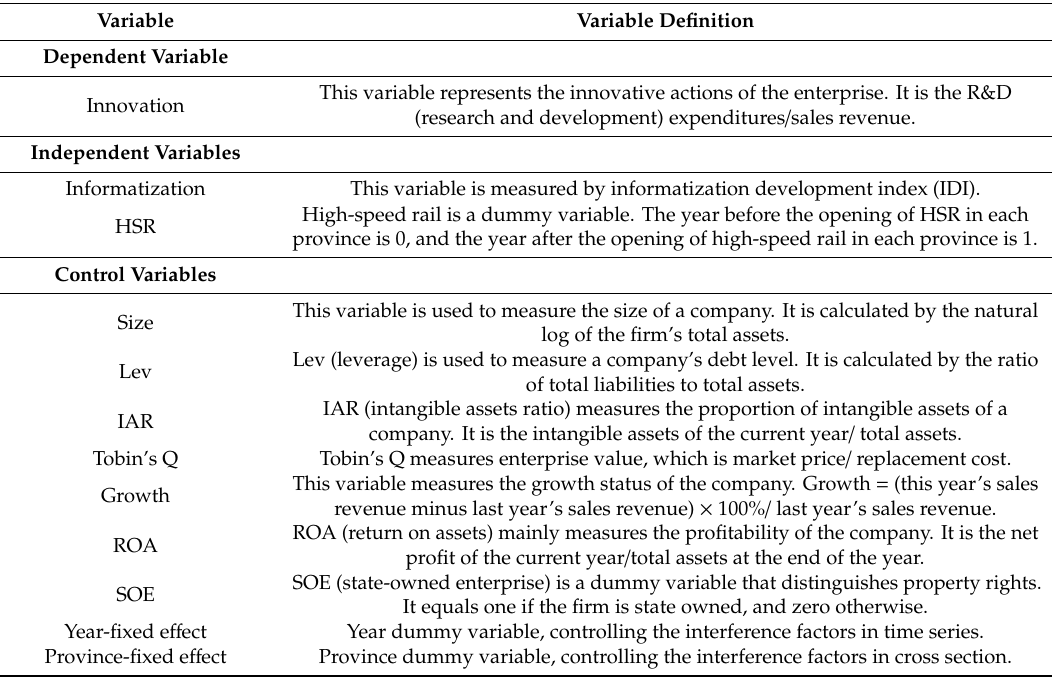
Table 1. Variable